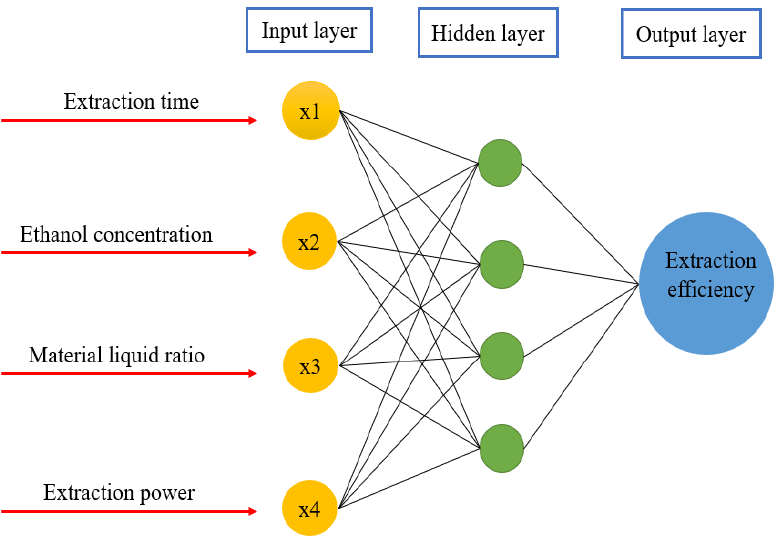
Figure 3. Structure of BP neural network.